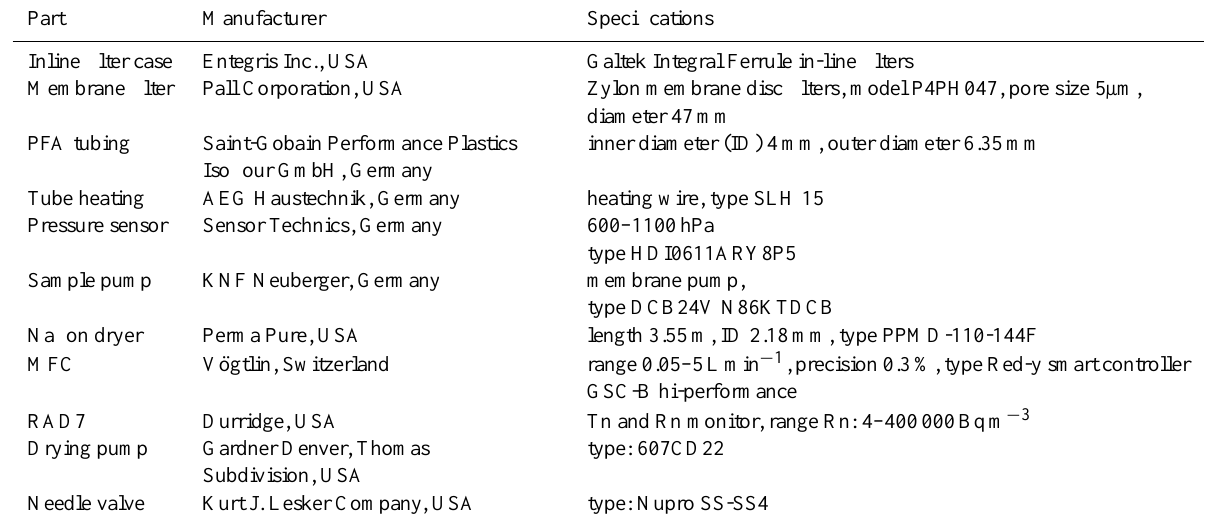
Table 1. Details of the hardware components used for the automated Tn and Rn profile